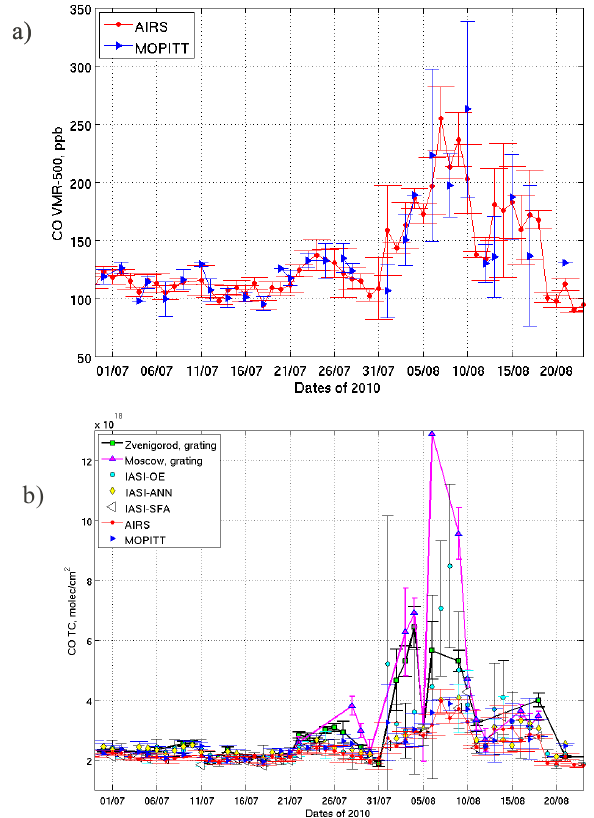
Fig. 11. VMR for 500hPa (a) and CO TC (b) averaged over the Moscow metropolitan area (54.0 ◦ –58.0 ◦ N, 36.0 ◦ –38.0 ◦ E) in com- parison to ground-based daily TC data.